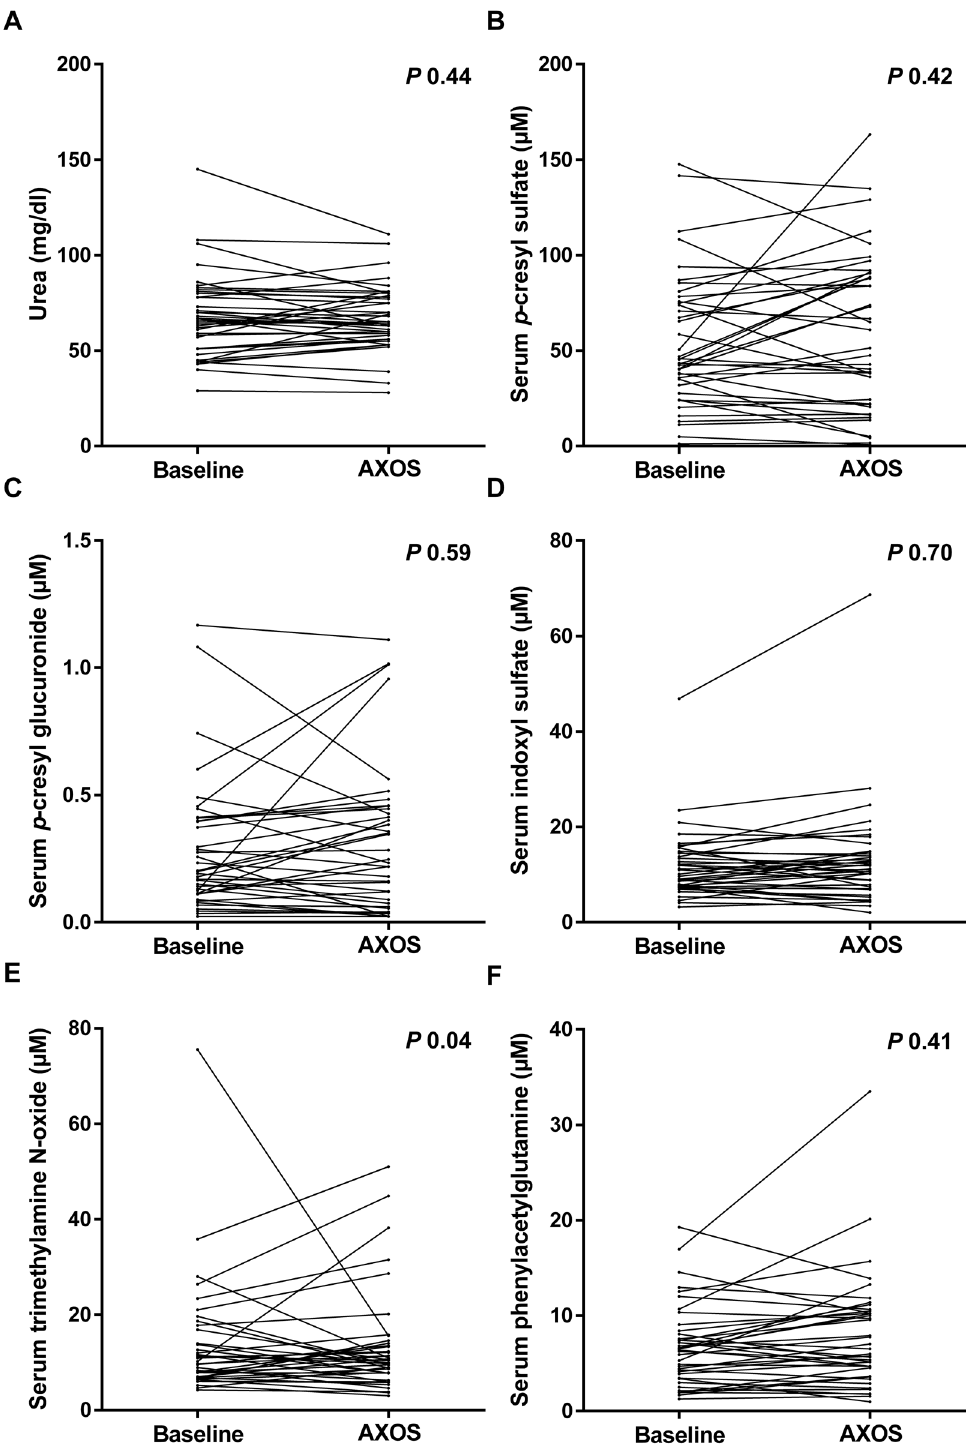
Fig 3. Serum levels of microbial metabolites during treatment with arabinoxylan oligosaccharides (AXOS). Evolution of serum urea (A), p -cresyl sulfate (B), p -cresyl glucuronide (C), indoxyl sulfate (D), trimethylamine N-oxide (E) and phenylacetylglutamine (F) during treatment with AXOS.